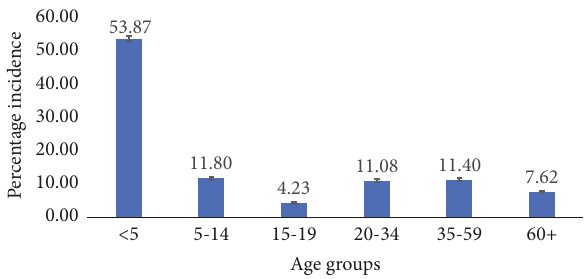
Figure 3: Percent incidence of diarrhea case in Jasikan District showing 95% confidence interval from 2012 to 2016 among age groups.